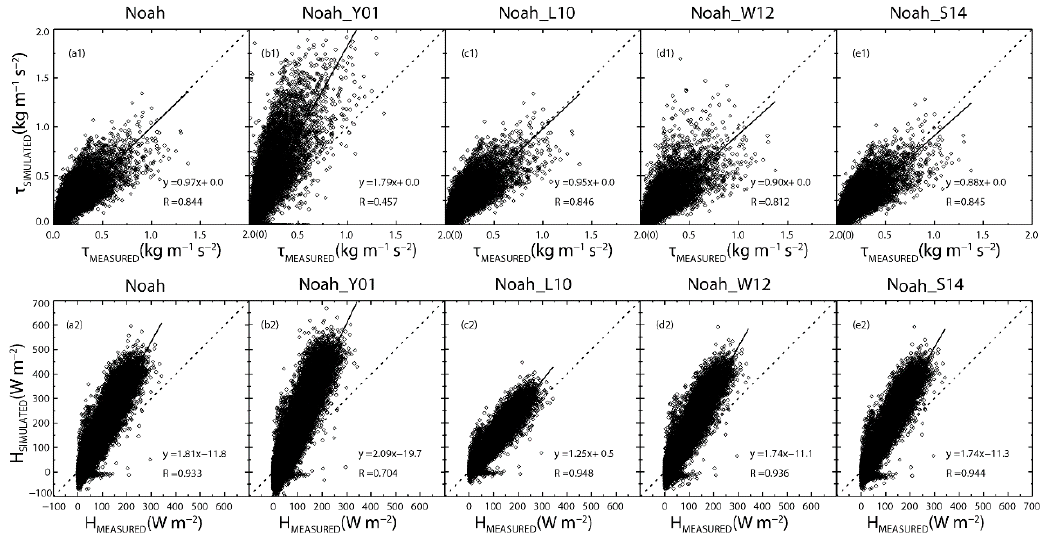
Figure 6. Comparison of simulated momentum and sensible heat fluxes with observed values under the unstable condition. The marker ( a – e ) represent scheme of Noah, Noah_Y01, Noah_L10, Noah_W12, and Noah_S14, respectively. The 1 and 2 represent momentum and sensible heat fluxes. For example, a1 means the simulated momentum with the scheme of Noah.